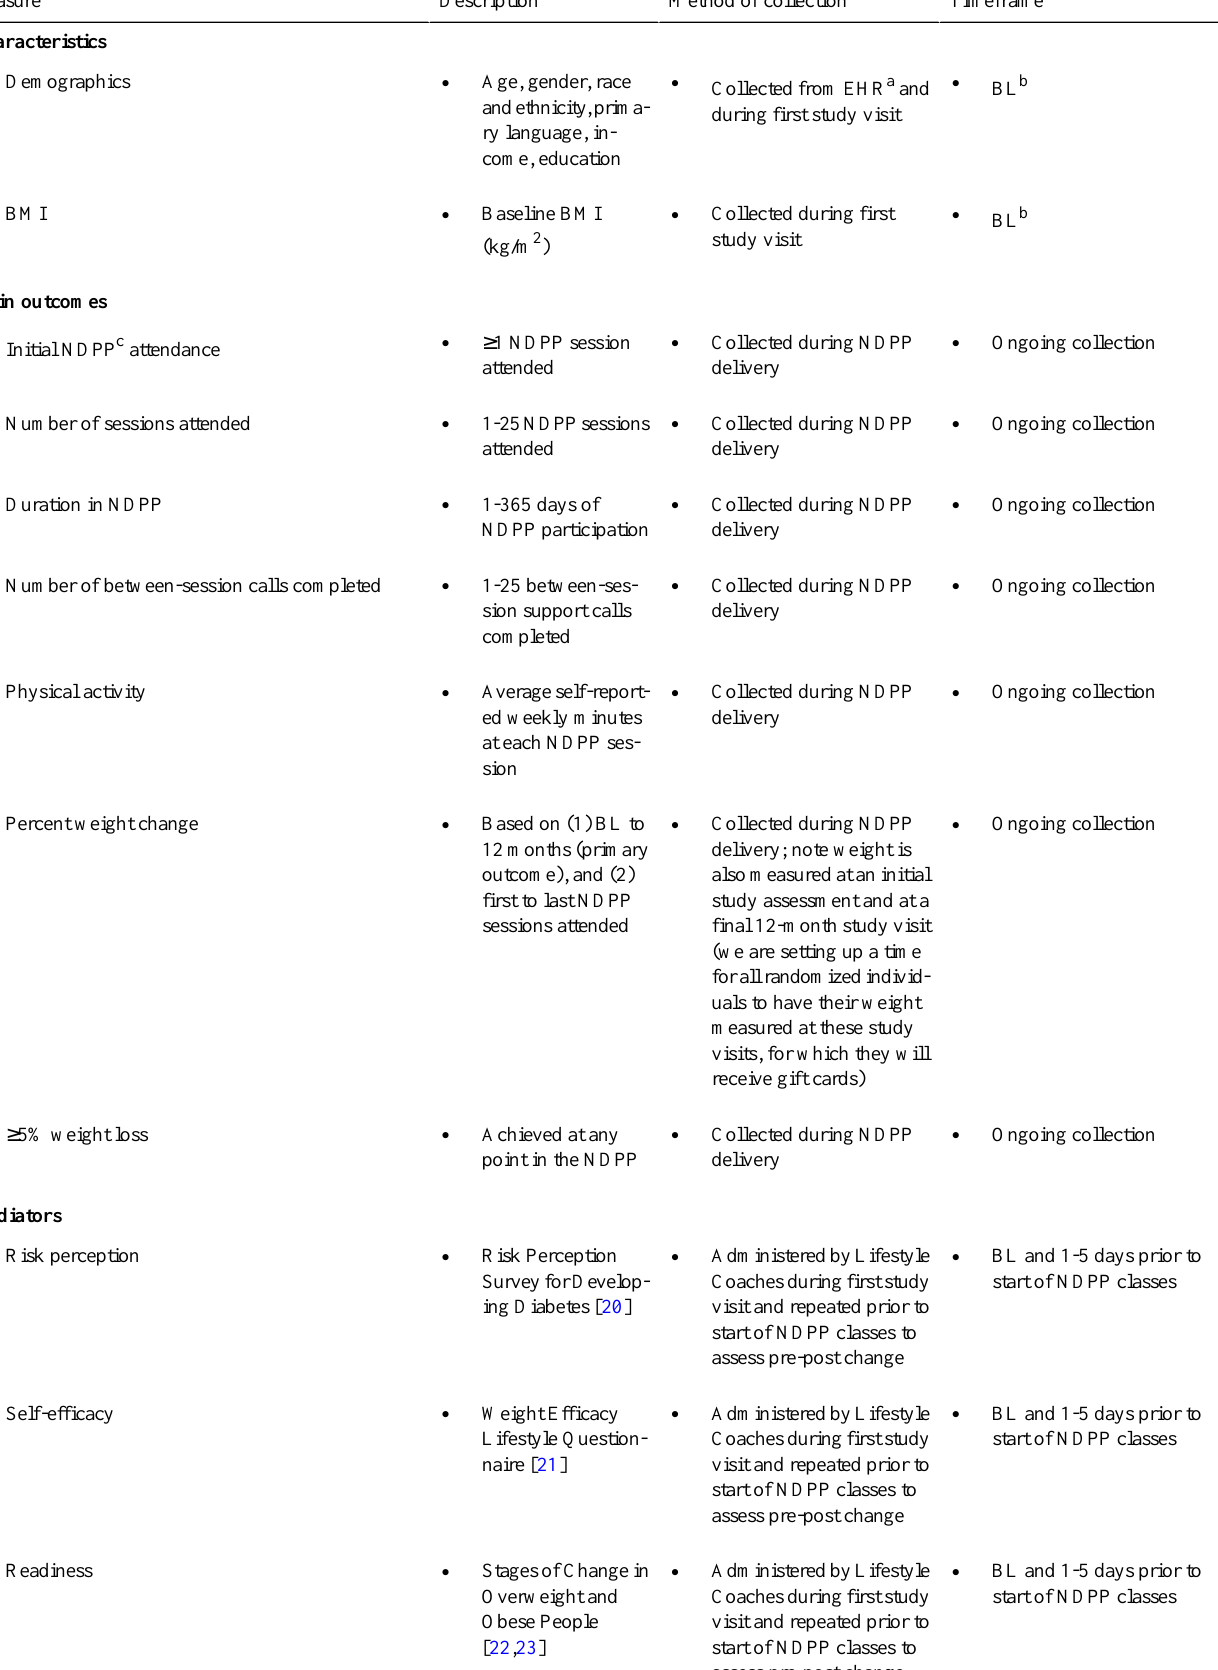
Table 1. Measures for randomized controlled trial of Pre-National Diabetes Prevention